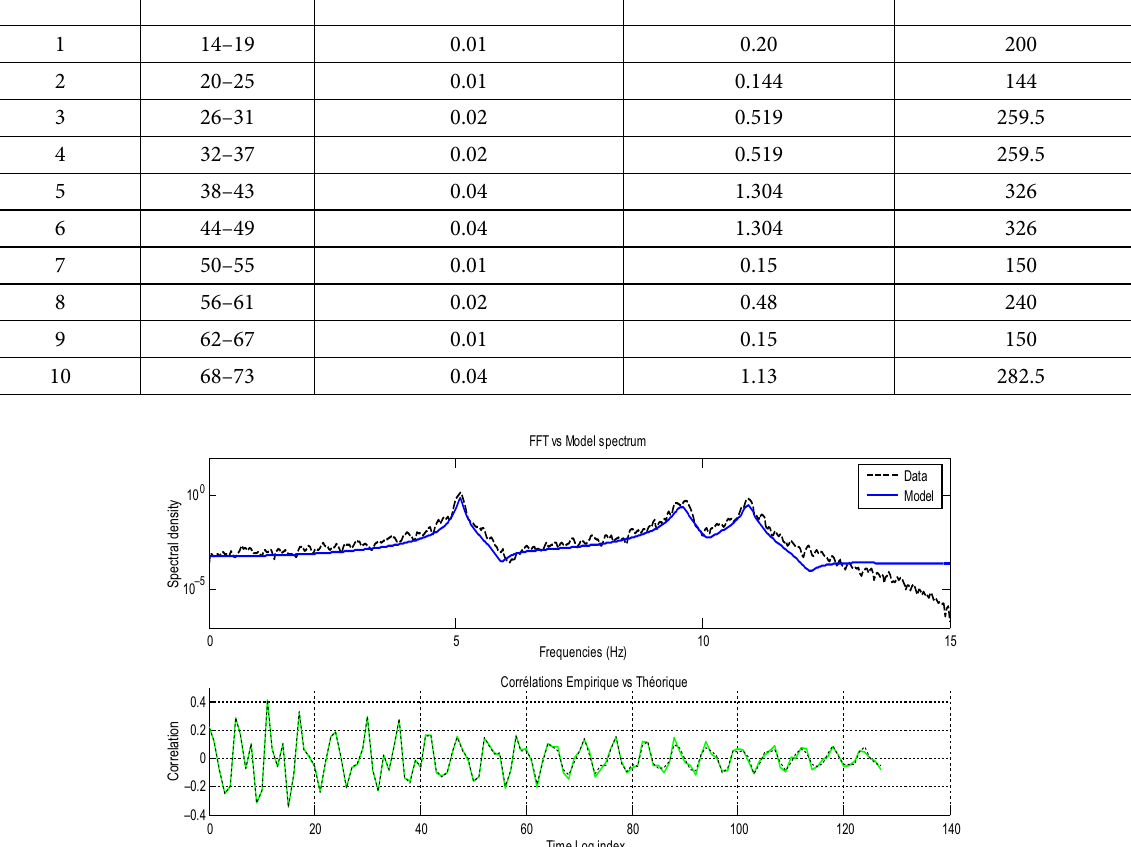
Fig. 7. Cross spectrum between sensors 1 and 5 of the Geiger